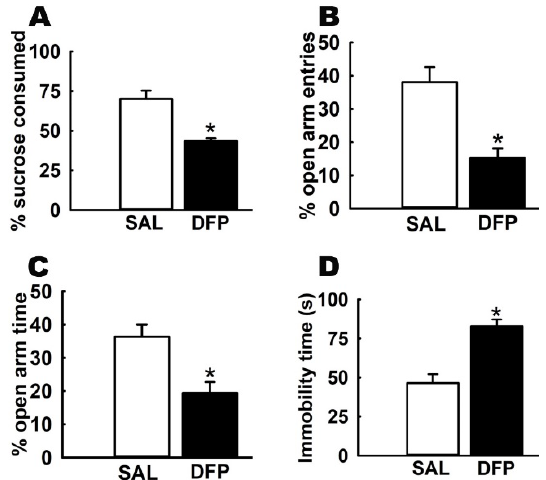
Figure 2. Repeated, low-dose DFP-treated rats exhibit signs of a depression-like condition. DFP exposure (0.5 mg / kg, s.c., 1 × daily for 5 days) produced significant alterations in rat behavior when assessed at 3 months following exposure, compared to saline-treated age-matched control rats. ( A ) SPT: decreased sucrose consumption. ( B , C ) EPM: decreased entries and time-spent in the open-arm of EPM ( D ) FST: increased immobility time (data expressed as mean ± SEM, * p < 0.05, t -test, n = 6 rats / test).